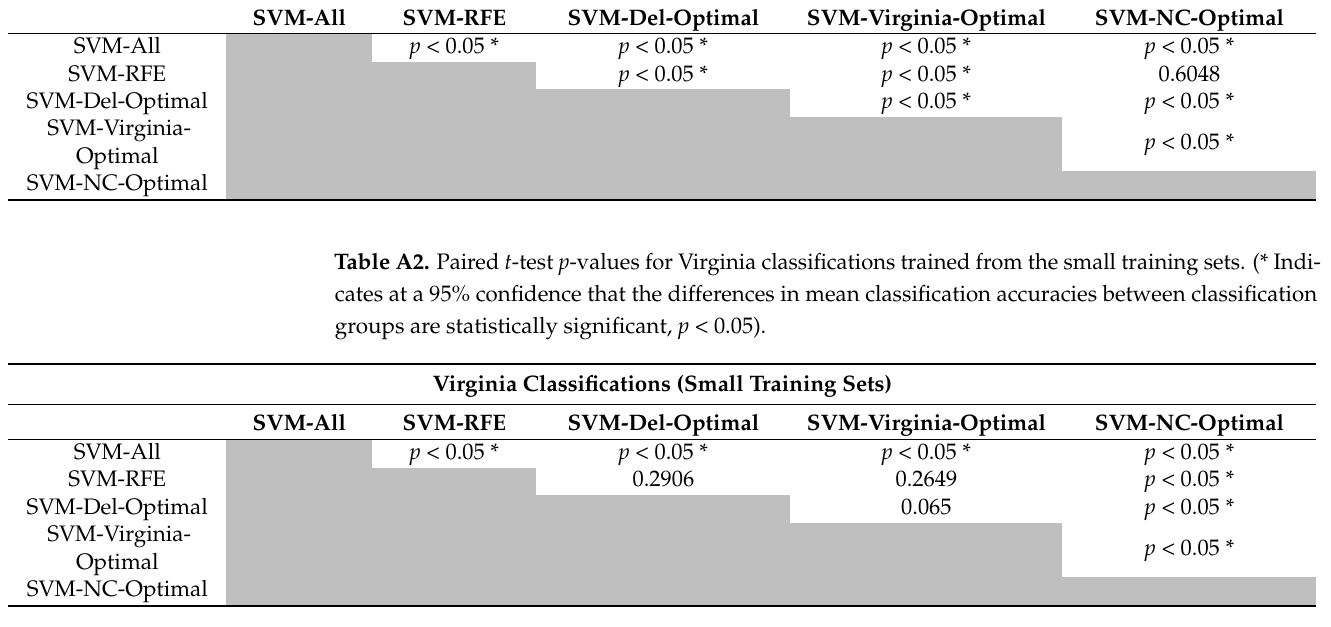
Table A3. Paired t -test p -values for North Carolina classifications trained from the small training sets. (* Indicates at a 95% confidence that the differences in mean classification accuracies between classification groups are statistically significant, p < 0.05).